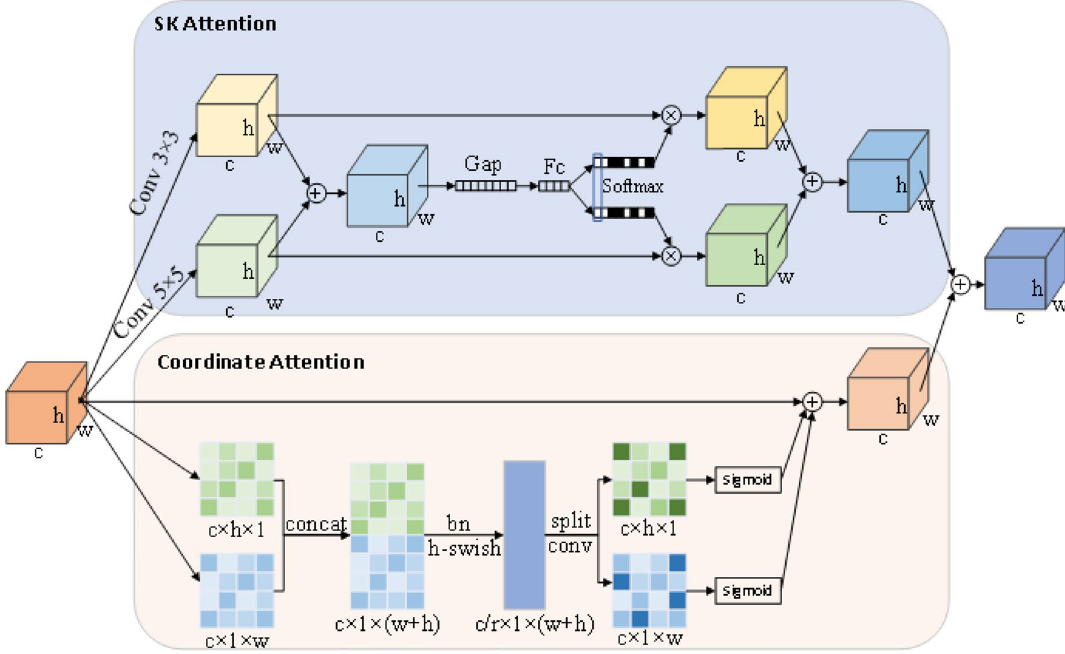
Figure 7. Designed DCSAM attention